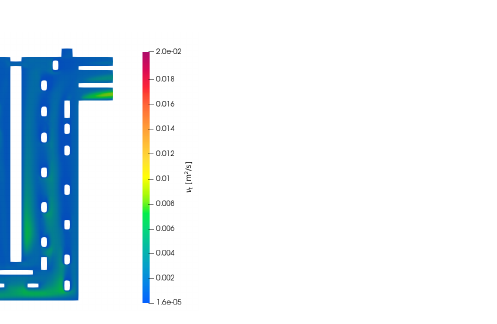
Figure 4. Turbulent kinematic viscosity ν t on the symmetry plane at t = 62 s of computation time.